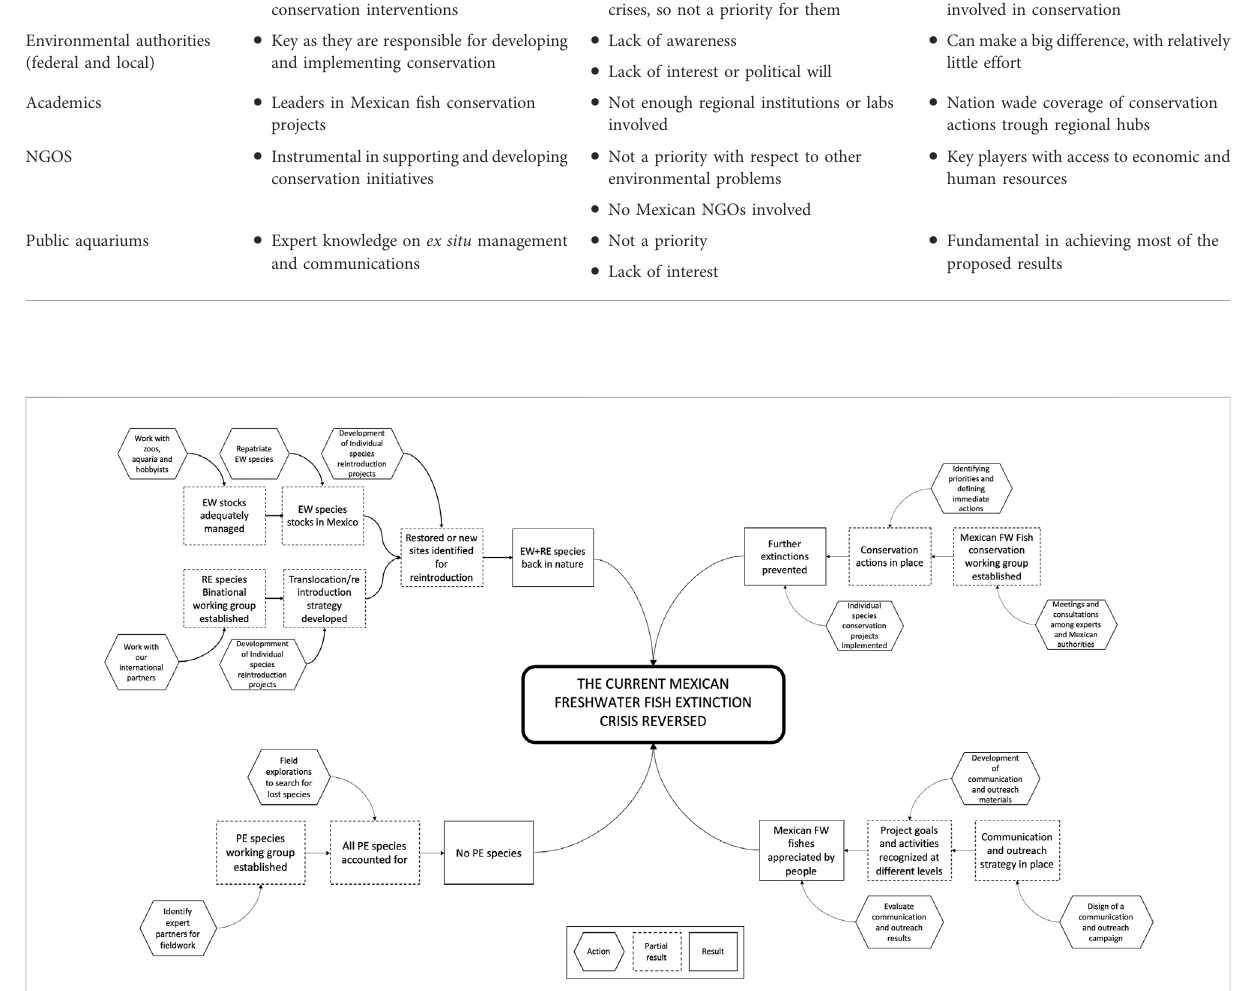
FIGURE 2 Theory of change (ToC) for reversing the current Mexican freshwater fi sh extinction